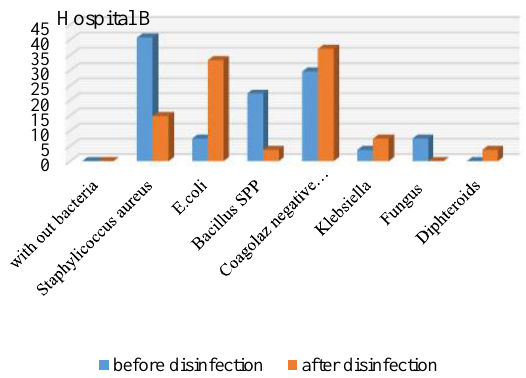
Fig. 4. Bacterial species in samples taken from hospital B before and after